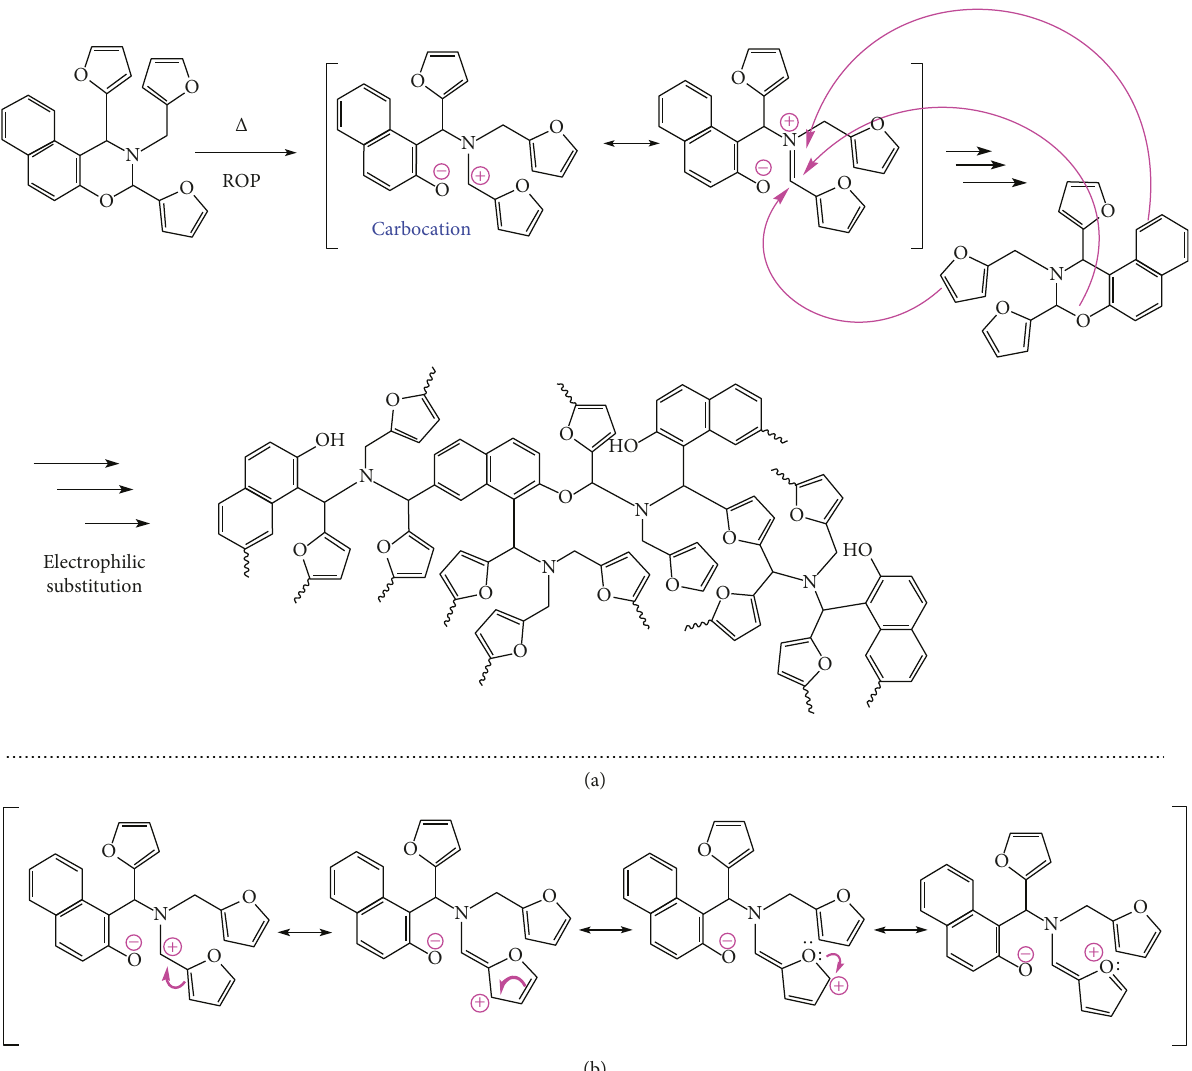
Figure 8: (a) Proposed mechanism for the polymerization of the compound Naft-Fu-Fu. (b) Stabilization of carbocation by resonance with the furan